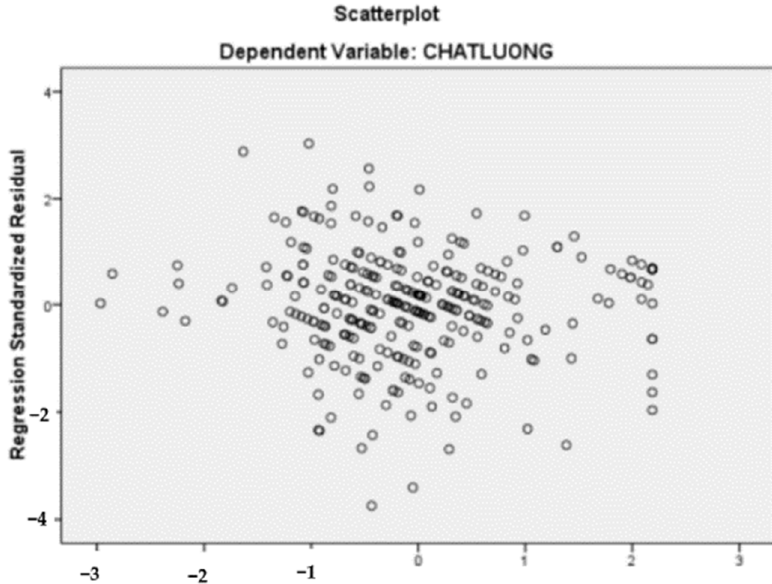
Figure 5. Regression standardized predicted value.